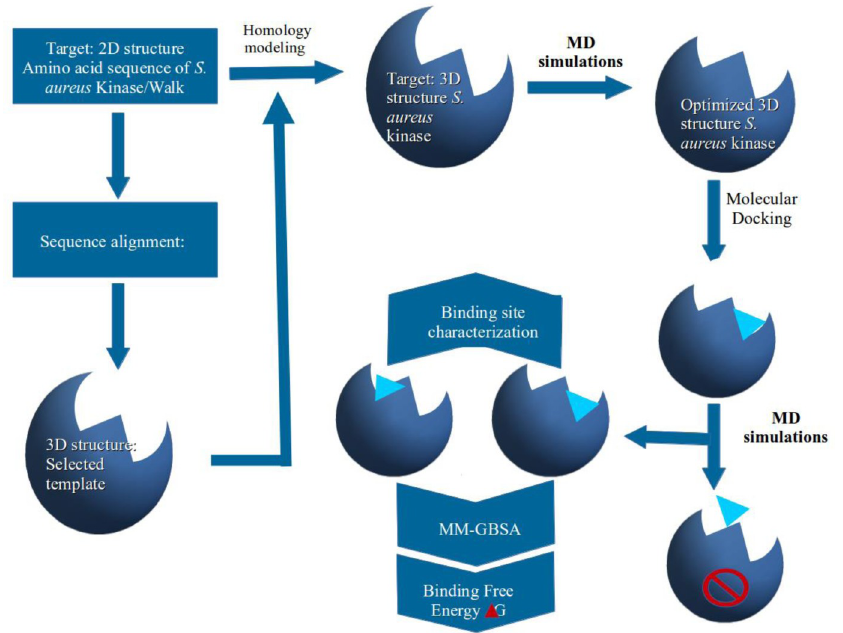
Fig 2. Sketch representation of the overall